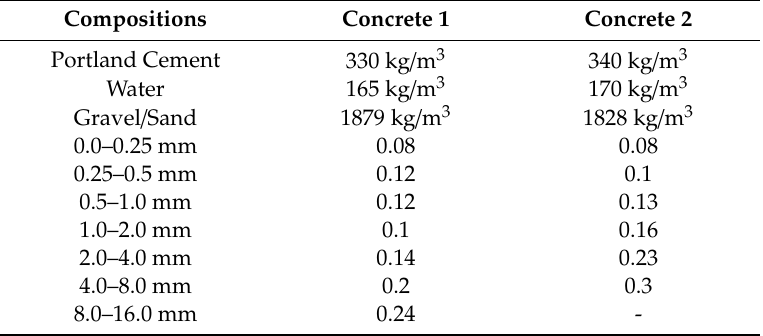
Table 4. Concrete mix proportions.